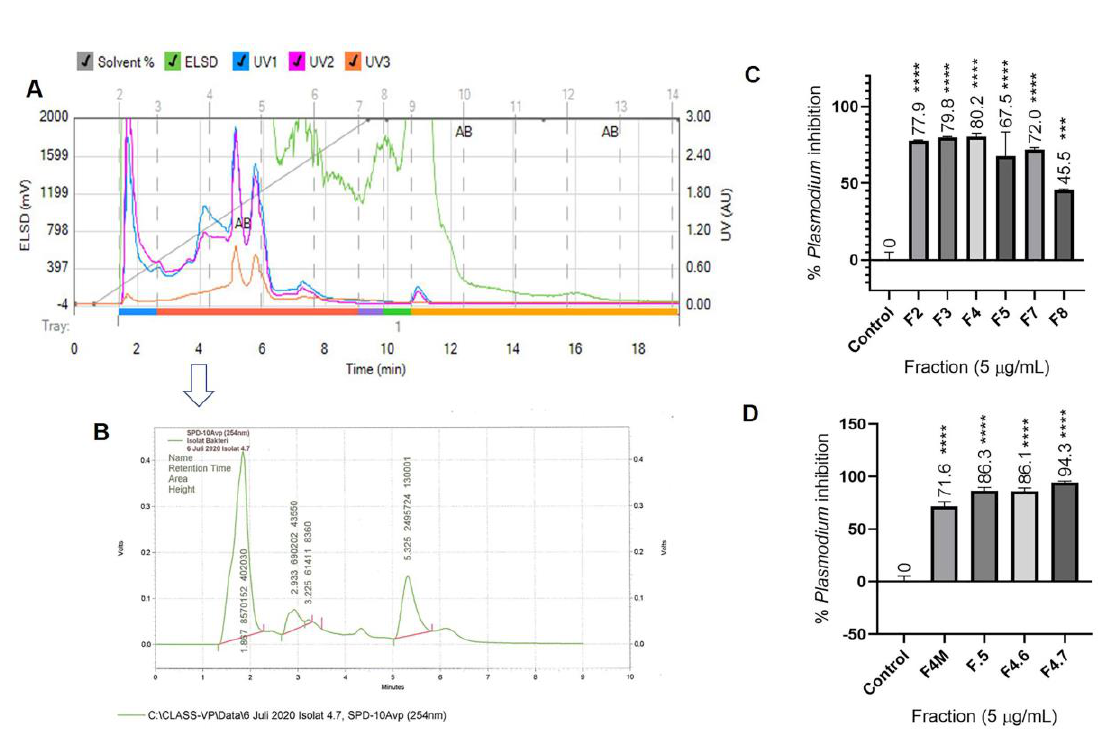
Figure 1. Flash chromatography of ethyl acetate-methanol extract using Reveleris™ using C18 column and eluent water: acetonitrile (A), HPLC profile of fraction 4.7 from column chromatography using Lichoprep Si 60 (40–63 µm) (B), antiplasmodial assay on P. falciparum 3D7 of active fraction from flash chromatography (C) and from column chromatography (D). Value are expressed as mean ± SD (*** p <0.001, **** p